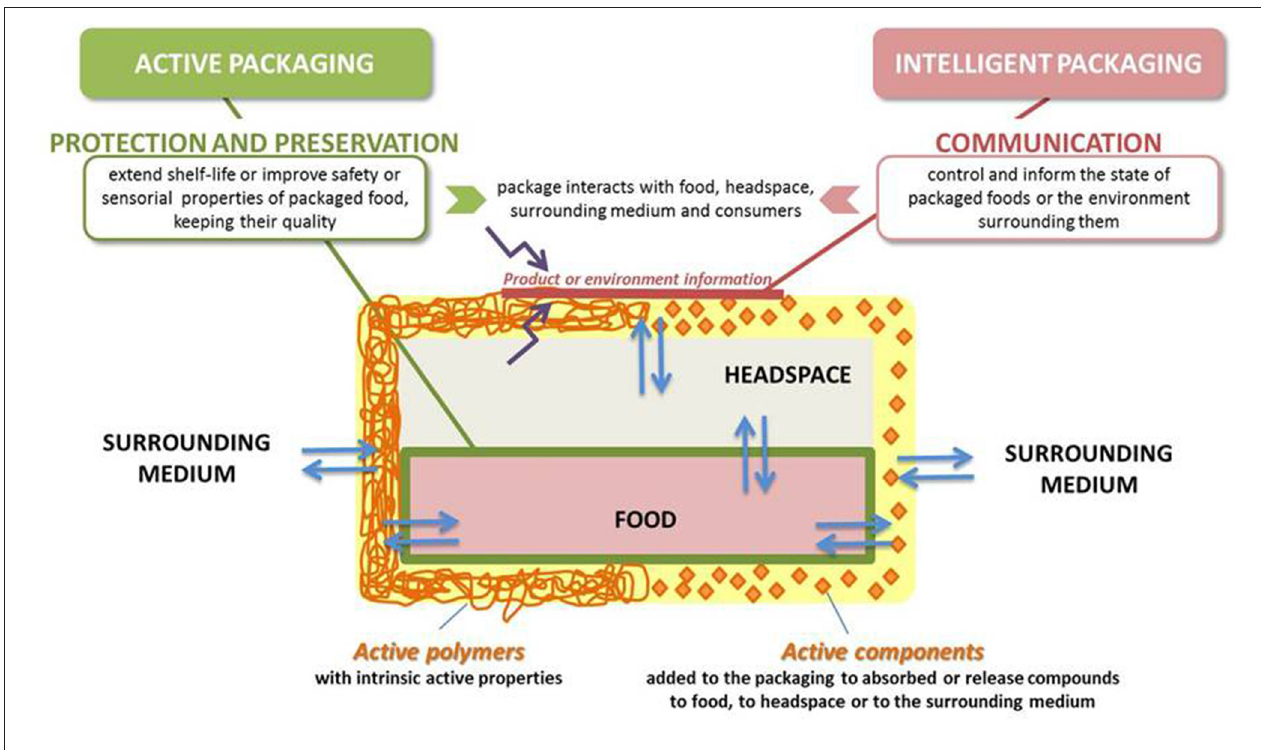
FIGURE 7 | Schematic diagram of active and intelligent packaging concepts.